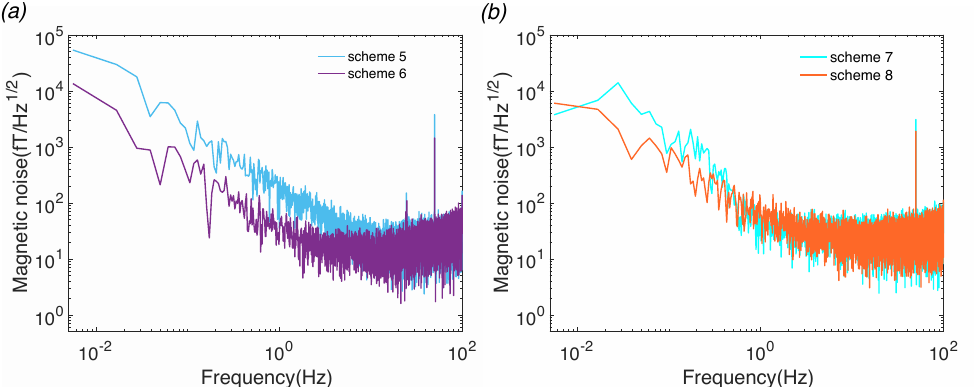
Figure 5. Magnetic noise measurement results of the SERF magnetometer under inner magnetic shield layers of different ( a ) amorphous + aluminum alloys, and ( b ) nanocrystalline + aluminum alloys.